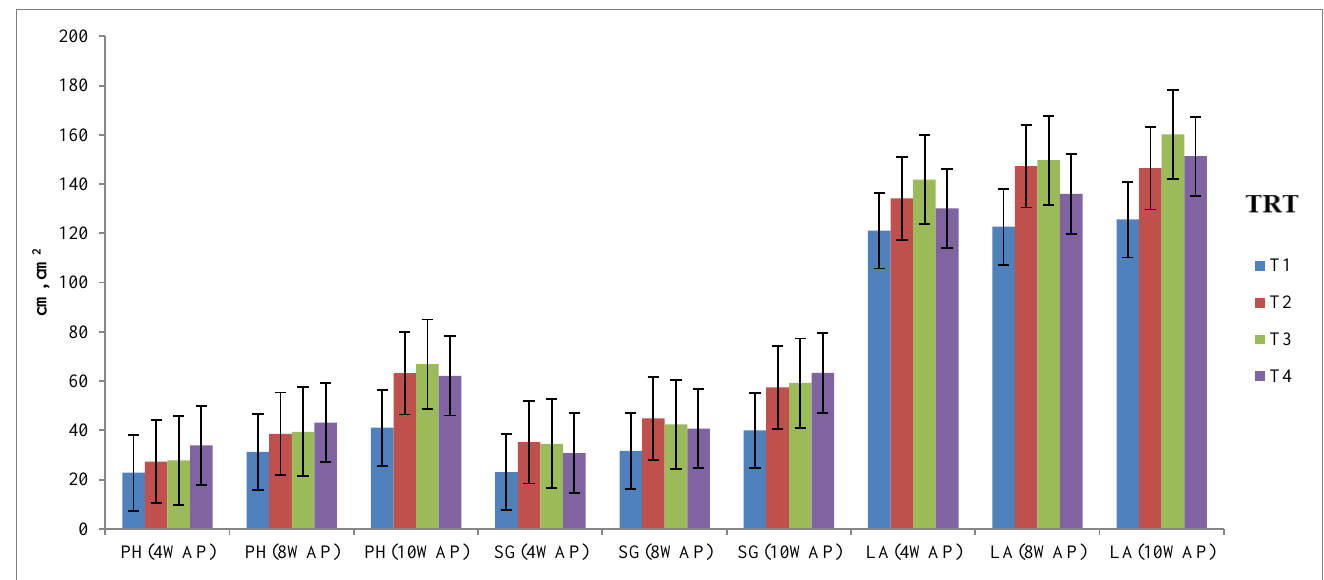
Figure 1. Mean values of vegetative parameters as affected by fertilizer application (okra-wasa-hyokr-1).